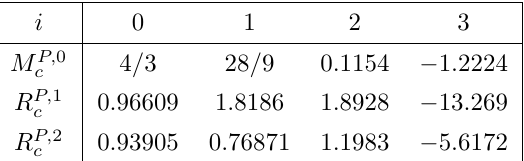
and r P;n for the 0-th moment (second row) and the ratios i i